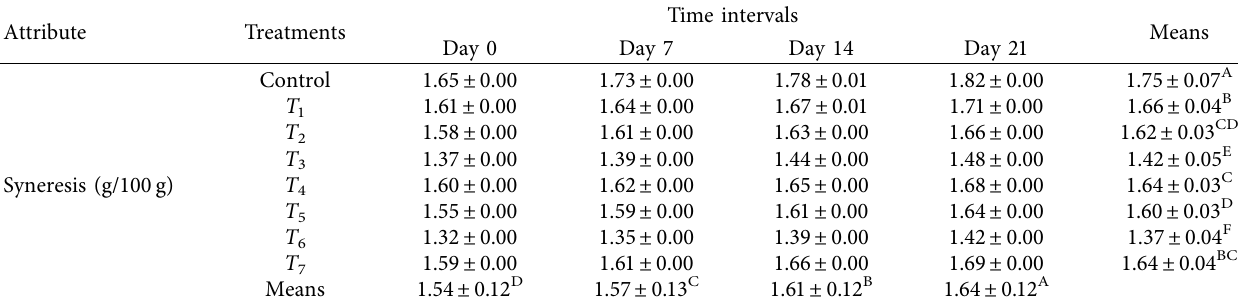
Table 7: Descriptive analysis for syneresis in different treatments. Values are given in (mean ± SD). Attribute